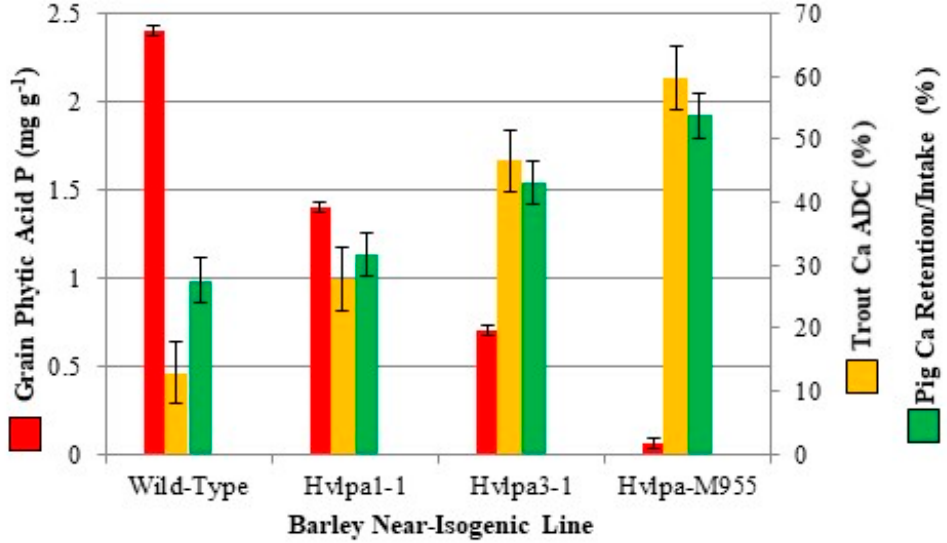
Figure 4. The highly linear negative relationship between dietary calcium bioavailability and grain phytic acid level, as observed in two separate studies, one with pigs [44] and one with trout [45]. Calcium bioavailability was measured in trout as “apparent digestibility coefficient” (ADC) and in pigs as “% retention / intake”. Animals were fed diets prepared with four barley near-isogenic lines produced in the same location: (1) wild-type (for grain phytic acid, the cv. Harrington); Hvlpa 1-1 with a ~40% reduction in grain phytic acid; Hvlpa 3-1 with a ~70% reduction in grain phytic acid; and Hvlpa -M955 with a > 95% reduction in grain phytic acid. Error bars are the standard deviation of the mean or “standard error” (SE) for each variable: grain phytic acid P, SE = 0.03, n = 3; Trout Ca ADC %, SE = 5.01, n = 2; Pig Ca retention / intake %, SE = 3.50, n = 5.